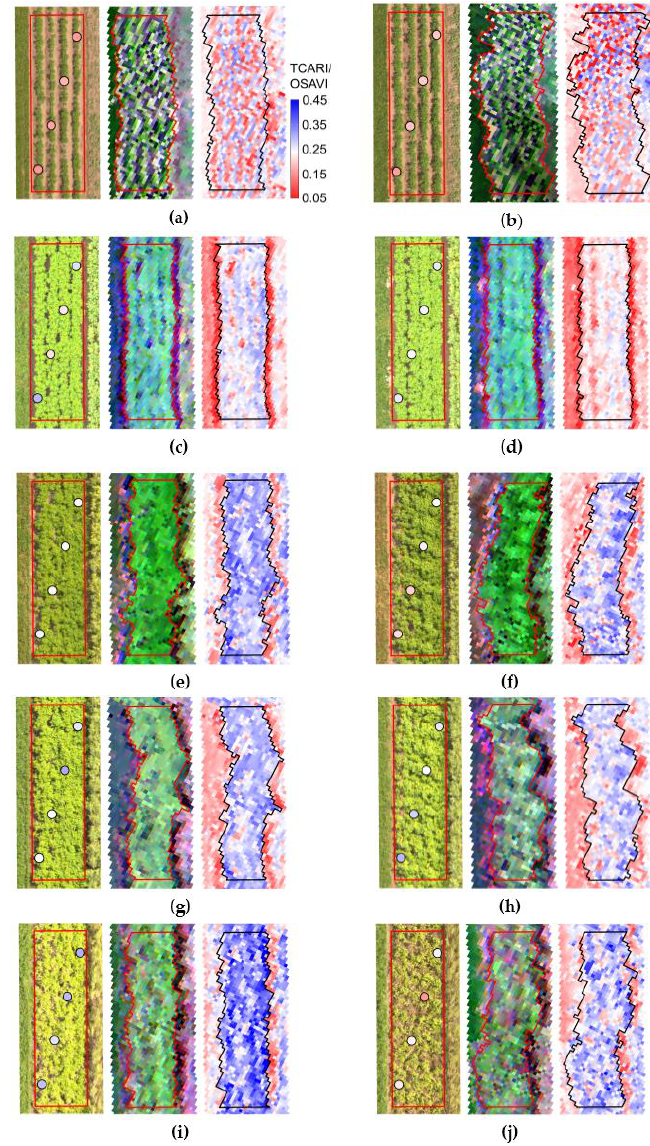
Figure 12. RGB orthomosaics (derived from images taken with the photogrammetric camera, as described in Section 2.2), true color composite from hyperspectral images (bands centered at 665, 555 and 485 nm as RGB layers, respectively) and values of TCARI/OSAVI for one plot from non-mixed ( a , c , e , g , i ) and mixed production systems ( b , d , f , h , j ), from 43 ( a , b ) to 99 DAP ( i , j ). Points over the orthoimages represent TCARI/OSAVI calculated from ground-based measurements and colors follow the same scale of pixel-wise results corresponding to the hyperspectral images. For this reason, in order to assess if data from both sensing approaches evaluated here yielded similar information sampling and discrimination potential for differences observed between production systems, a comparison of vegetation indices distributions is presented in Figure 13 and values of a parameter (B-coefficient) corresponding to this comparison is provided in Table A2.